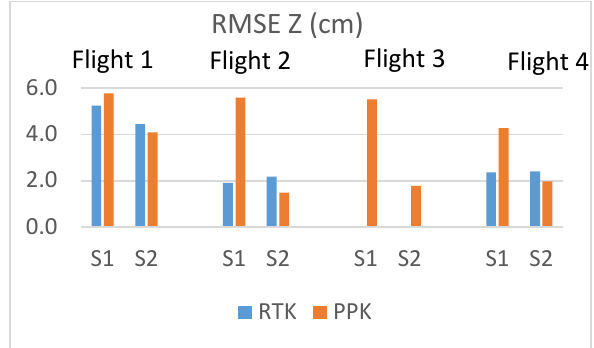
Figure 9. RMSE in elevations of CP with 4-GCP and 8-GCP self-calibrating BBA, with and without GNSS